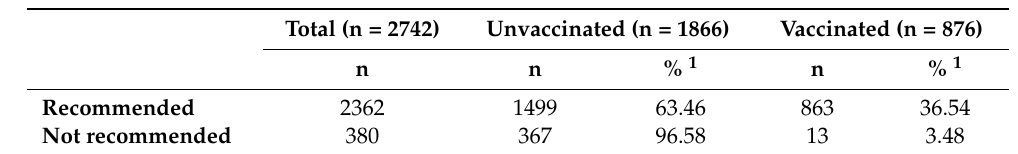
Table 3. Recommended vaccination by vaccination